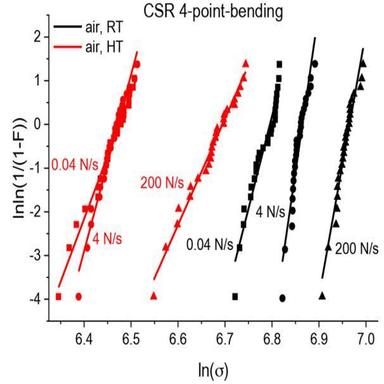
Weibull diagram from 4PB tests for different load rates at RT and 1000 °C.